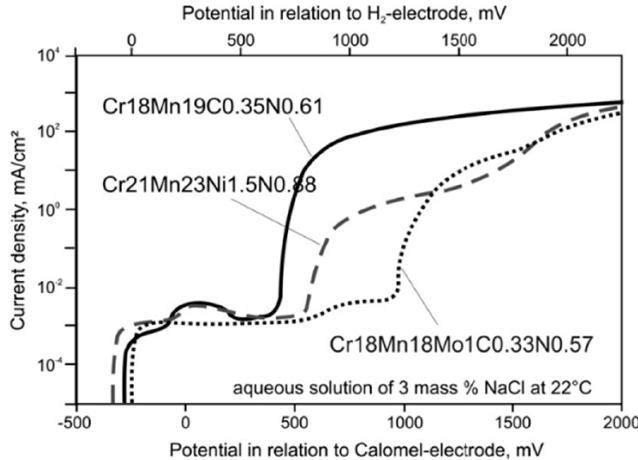
Figure 16. Potentiodynamic curves of steels Cr18Mn19C0.35N0.61, Cr18Mn18Mo1C0.33N0.57, and Cr21Mn23Ni1.5N0.88 [115]. (Reproduced with permission from refs. [115] . Copyright (2008 ),